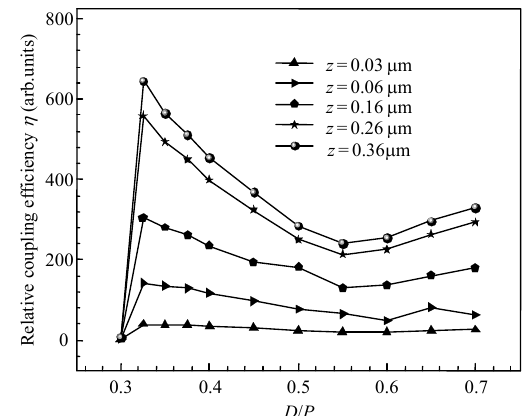
Fig. 2 Distribution of E at z = 0.11  m x - y plane. z